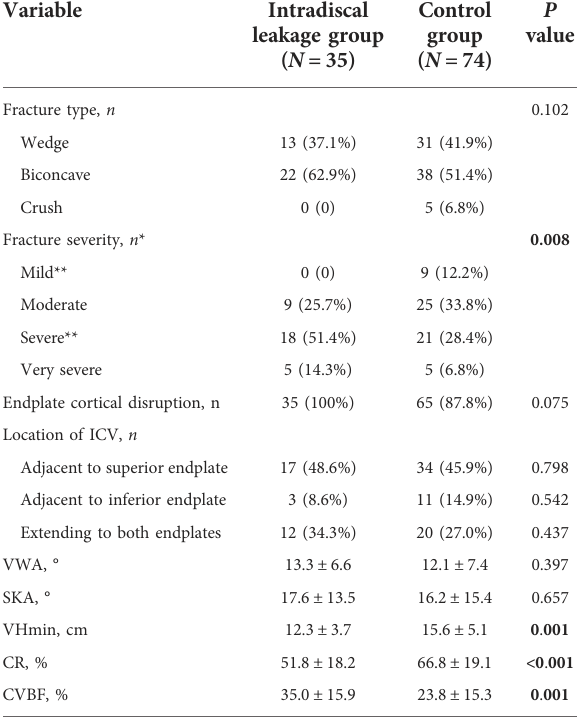
TABLE 3 Univariate analysis of radiologic data for intradiscal leakage.